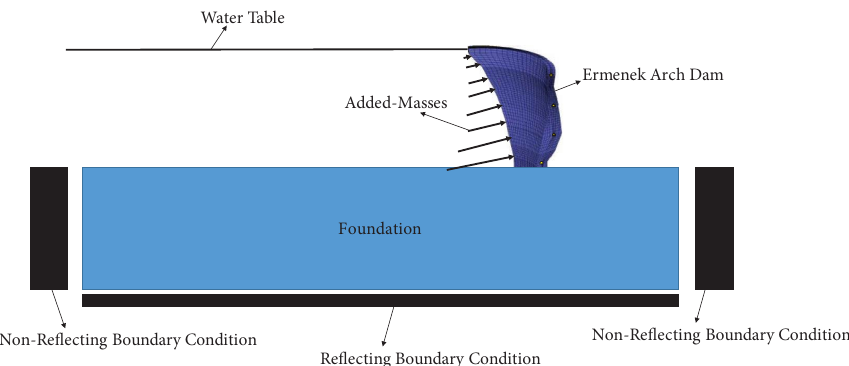
Figure 5: View of water loads and water table. Table 2: Characteristic properties of strong ground motions